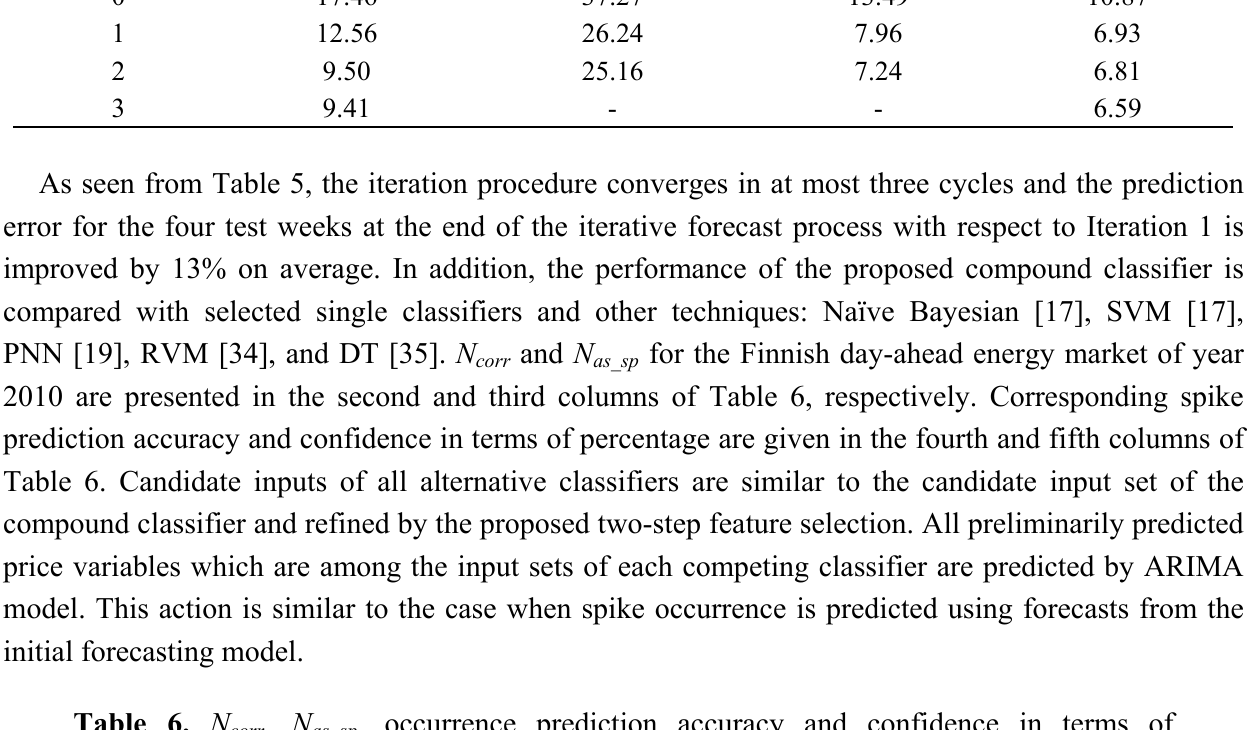
, N , occurrence prediction accuracy and confidence in terms of Table 6. N corr as_sp percentage (%) for price spike classification in the Finnish day-ahead energy market of year